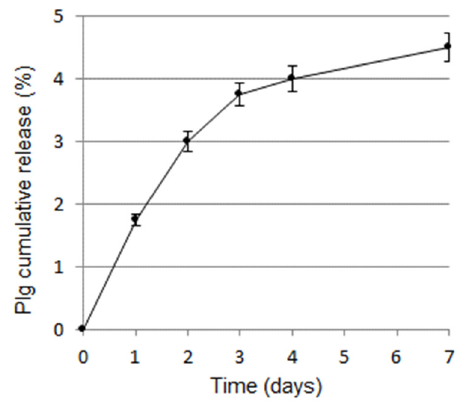
Figure 5. Release kinetic of Plg from Plg-loaded fibrin